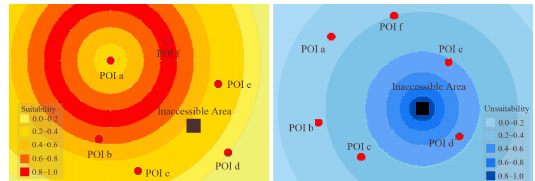
Figure 12. The accessible buffer of POI (left), inaccessible buffer of one POO (right)